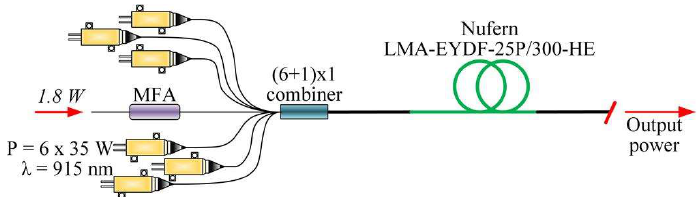
Figure 3. Experimental setup of the third MOPA stage—high-power amplifier EYDFA.